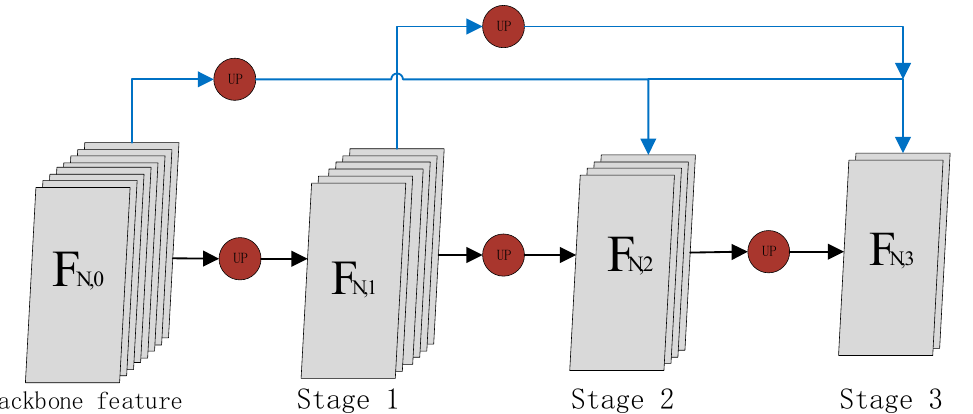
Figure 2. The overall structure of cross-stage feature fusion module, the blue lines in the figure in- dicate the skip connection of the cross-stage module. 𝐹 (cid:3015),(cid:2868) indicates the backbone network feature. 𝐹 (cid:3015),(cid:2869) , 𝐹 (cid:3015),(cid:2870) , and 𝐹 (cid:3015),(cid:2871) indicate the feature of stage 1,2,3 respectively. The feature information of the first stage comes from the backbone feature, the feature information of the second stage fuses the feature of the first stage and the feature information of the backbone feature, and the feature infor- mation of the third stage fuses the backbone features, the first stage and the second stage.